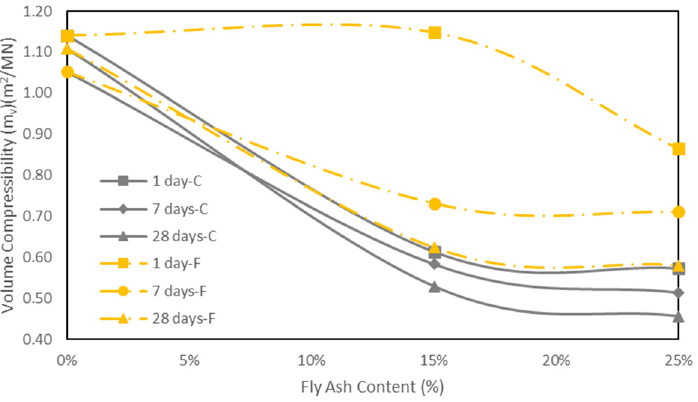
Figure 13. Variation of coefficient of m v with different fly ash contents at effective pressure of 80 kPa and different curing times.